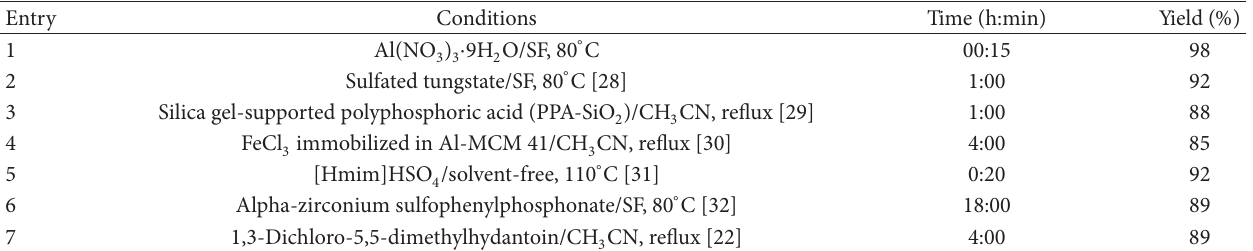
T 5: Biginelli synthesis of 5-ethoxycarbonyl-6-methyl-4-phenyl-3,4-dihydropyrimidin-2(1 H )-one: